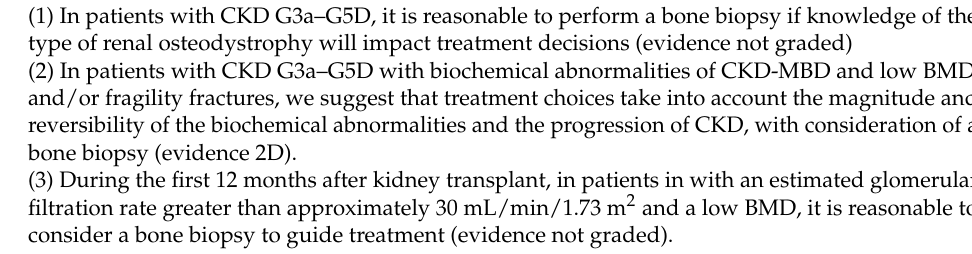
Table 2. Synthetic updated indications for bone biopsy in CKD.